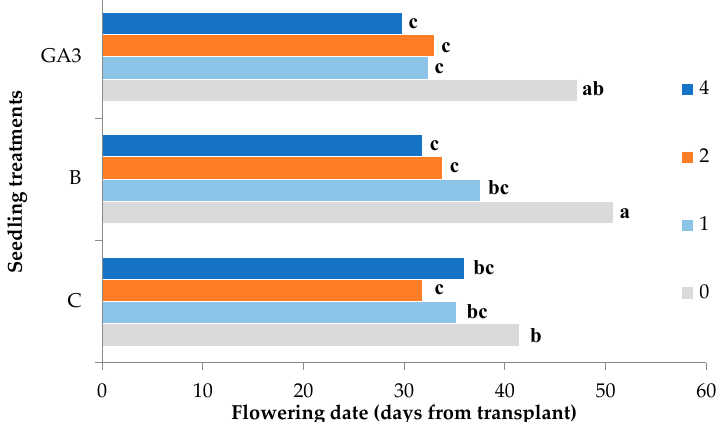
Figure 13. Effect of the seedling treatments (C, untreated control, B, bacterial biostimulant, GA3, gibberellic acid spray 10 − 5 M) and the nursery fertigation rates (0, 1, 2 and 4 g L − 1 of NPK 20 ‐ 20 ‐ 20) on the flowering date of Solanum lycopersicum ‘Marmande’ plants (bars with different letters are significantly different at p < 0.05 according to the LSD test).